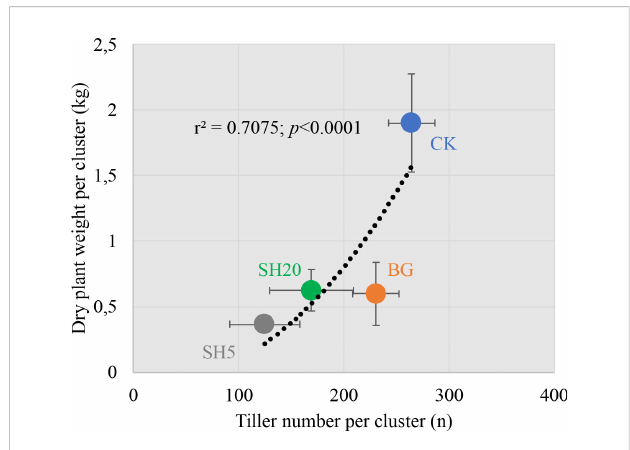
FIGURE 6 Plot of dry plant weight per cluster (kg/cluster) in four treatments against the tiller number per cluster